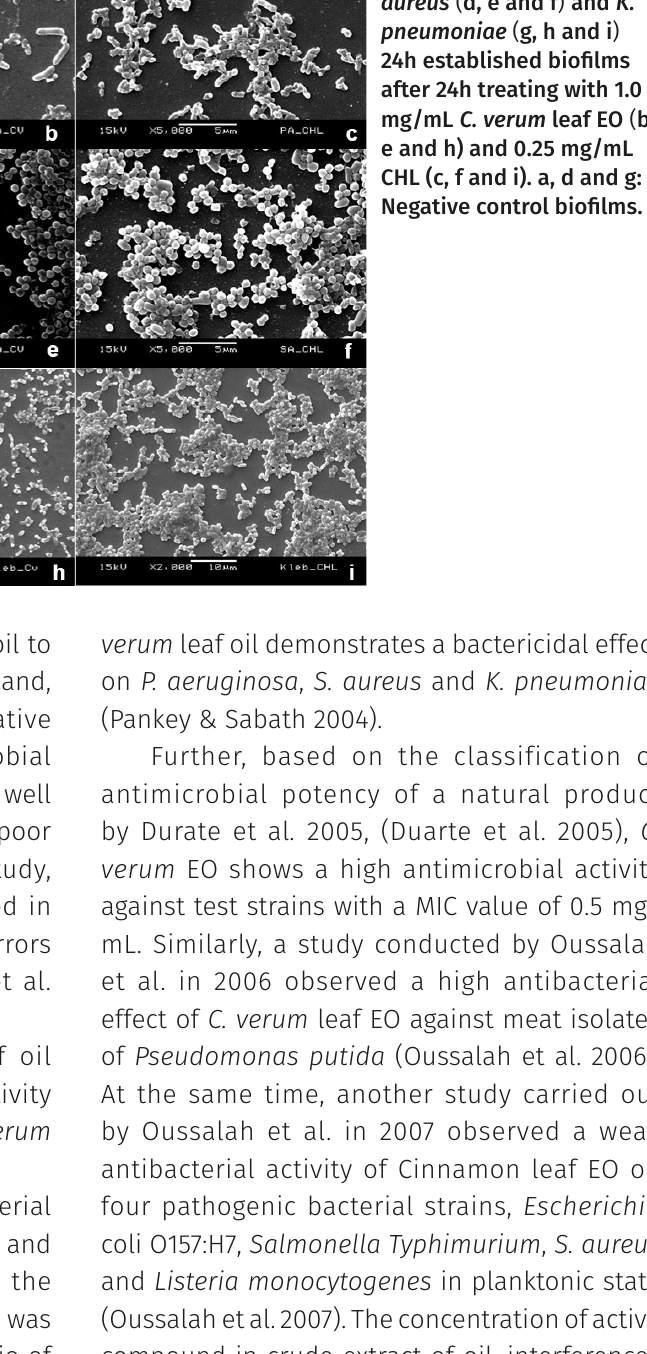
Figure 3. SEM images of P. aeruginosa ( a, b and c ), S. aureus ( d, e and f ) and K. pneumoniae ( g, h and i ) 24h established biofilms after 24h treating with 1.0 mg/mL C. verum leaf EO ( b, e and h) and 0.25 mg/mL CHL (c, f and i). a, d and g: Negative control